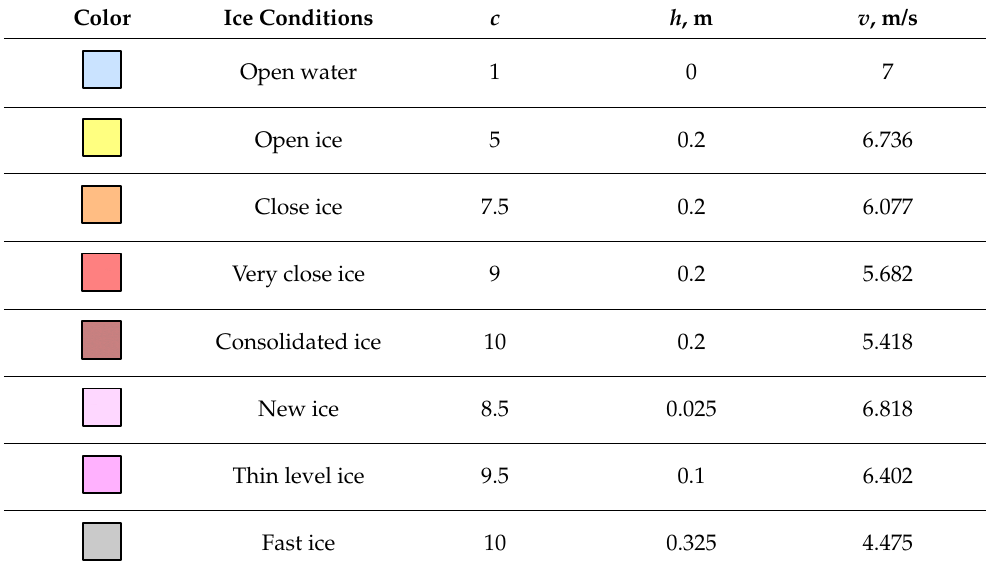
Table 2. Legend for color areas of the images in Figure 3a,b and Figure 4a–f; v is the design speed for the ship considered in the case study.